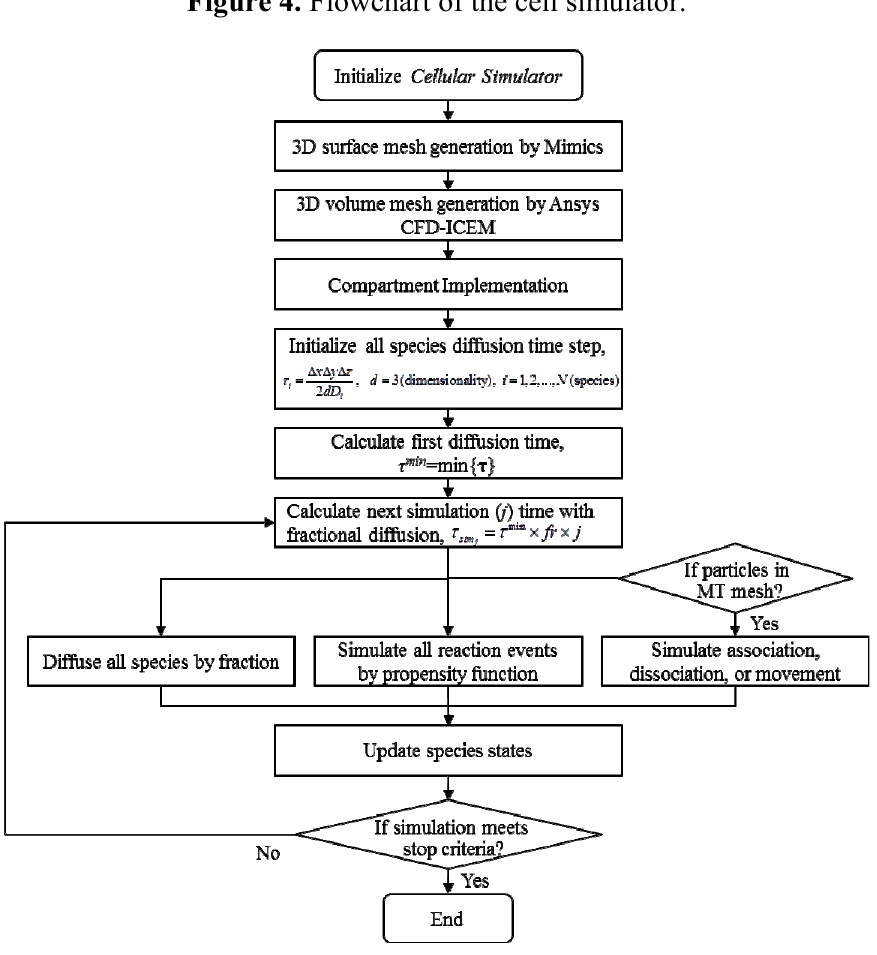
Figure 4. Flowchart of the cell